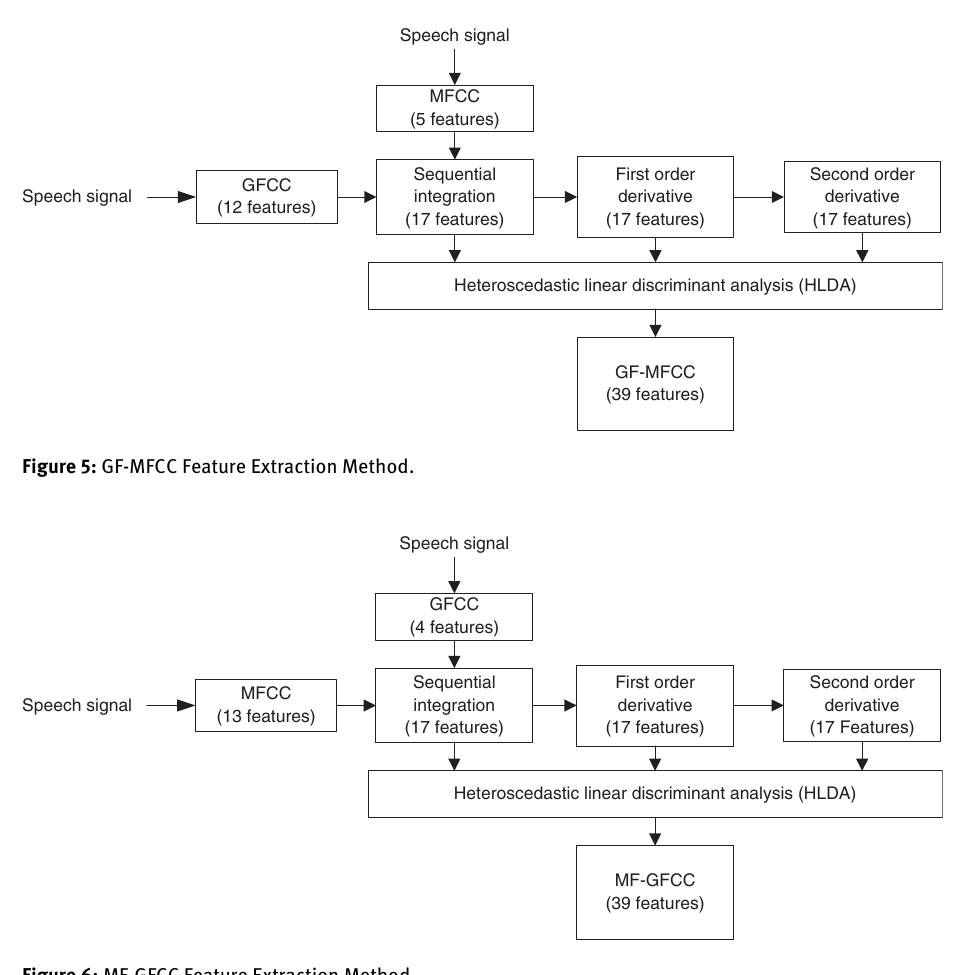
Figure 6: MF-GFCC Feature Extraction